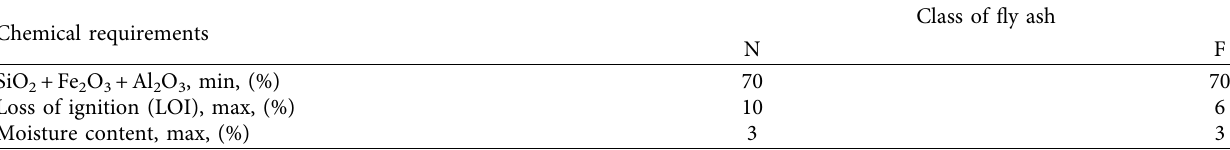
Table 8: Standard chemical compositions of fly ash [22].